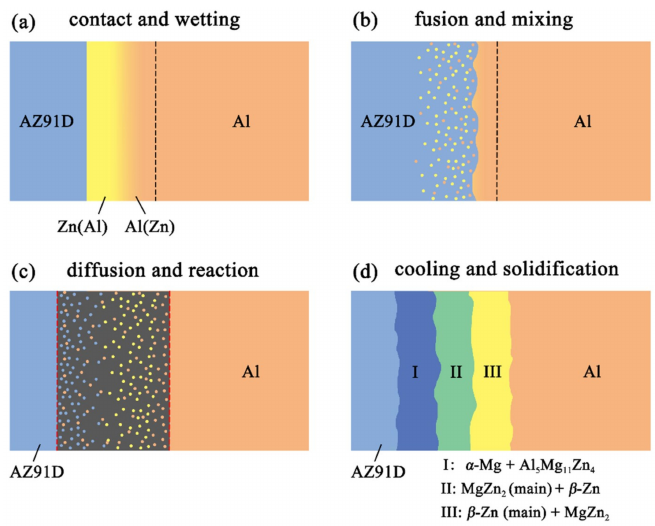
Figure 12. Schematic illustrations of the interface formation process in arc-sprayed Al / AZ91D with a Zn interlayer: The whole Al / Zn double-deck coating transformed into xAl-(1 − x)Zn coating (x > 50%).